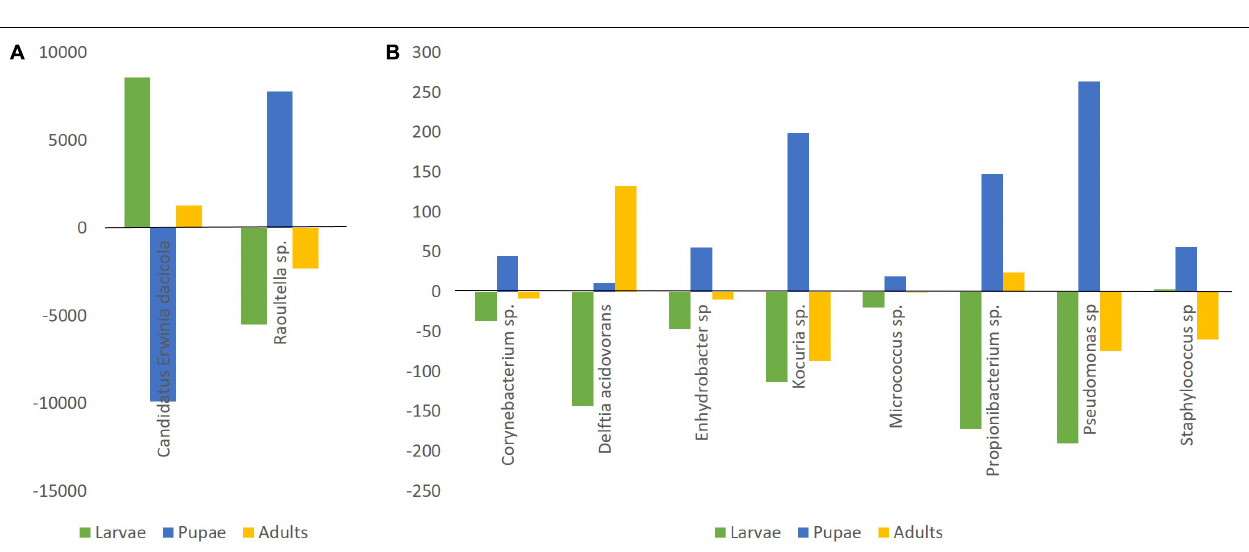
FIGURE 4 | UpSet plot summarizing the presence of OTUs in the different olive fly samples. The bottom left horizontal bars shows the total number of OTUs per sample. The circles in the panel’s matrix represent the unique and common parts in Venn diagram sections (unique and overlapping OTUs). Connected black circles indicate a certain intersection of OTUs between treatments, while grey circles show no intersection. The top vertical columns summarize the number of OTUs for each unique or overlapping combination. M stands for “Galega” cultivar and R for “Redondil” cultivar, followed by A for adults, P for pupae, and L for larvae.